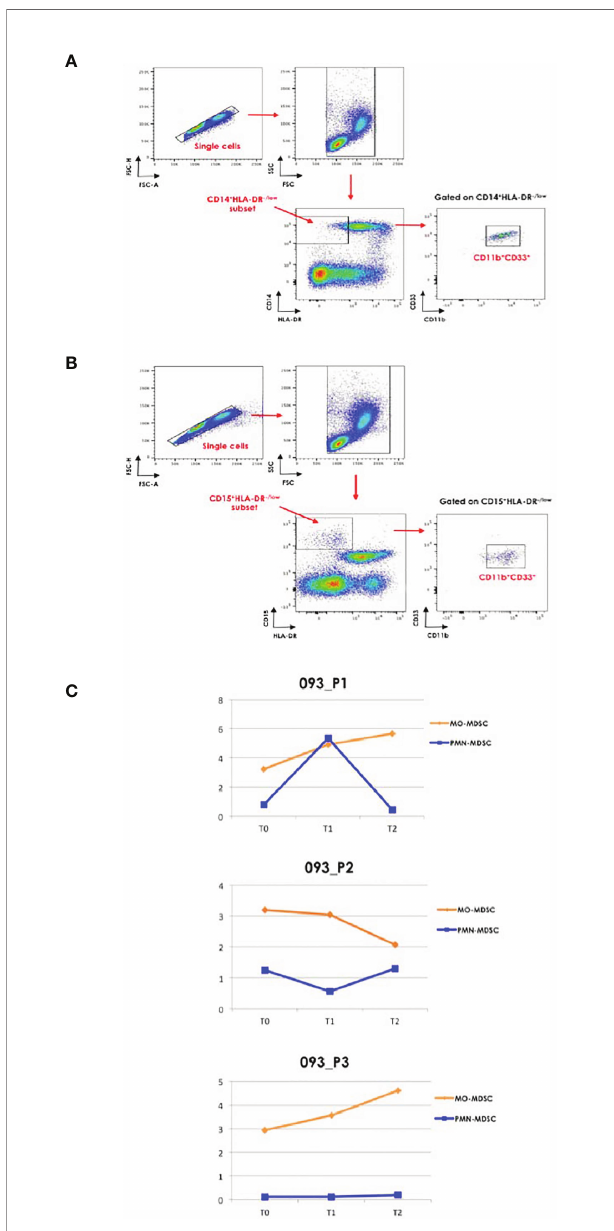
FIGURE 2 | Flow cytometric characterization of MDSC. Gating strategy was used to de fi ne MDSC subpopulations. After exclusion of doublets, (A) , CD14 + HLA-DR -/low and (B) , CD15 + HLA-DR -/low cell subsets were gated and the proportion of CD11b + CD33 + was evaluated. (C) , The graphs report the changes in the percentage of MO-MDSC-LC and PMN-MDSC-LC in the three clinical cases at T0, T1 and